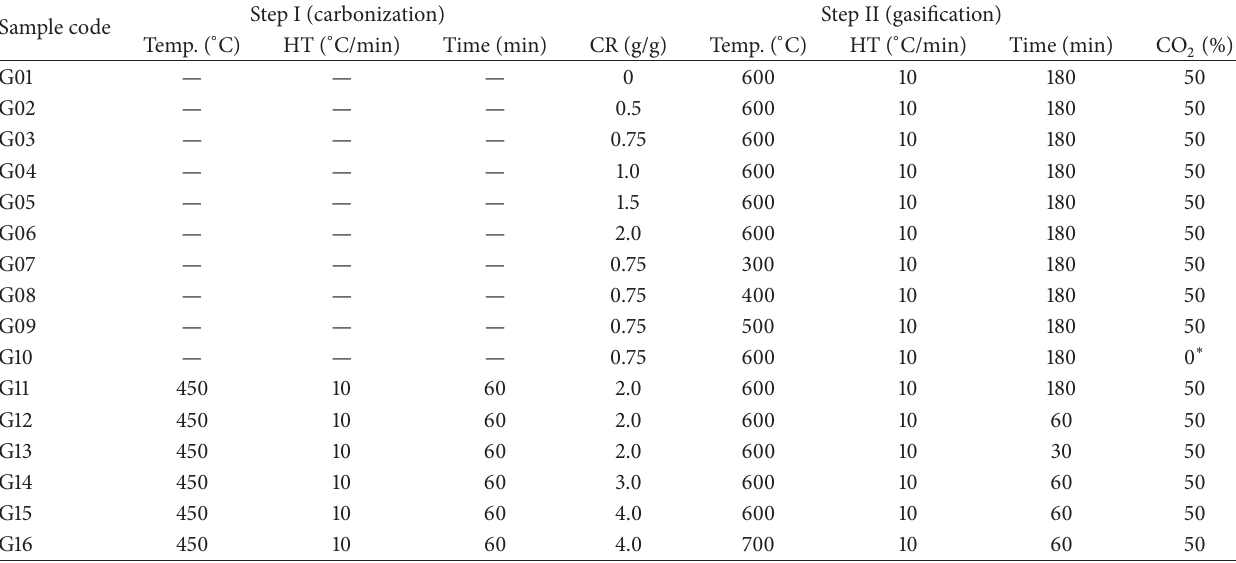
Table 1: Experimental conditions for studying low temperature catalytic gasification of coconut shell. Sample code